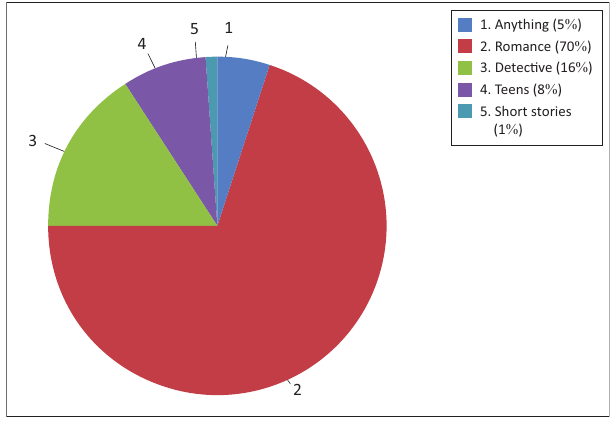
FIGURE 4: Reasons why the women read.